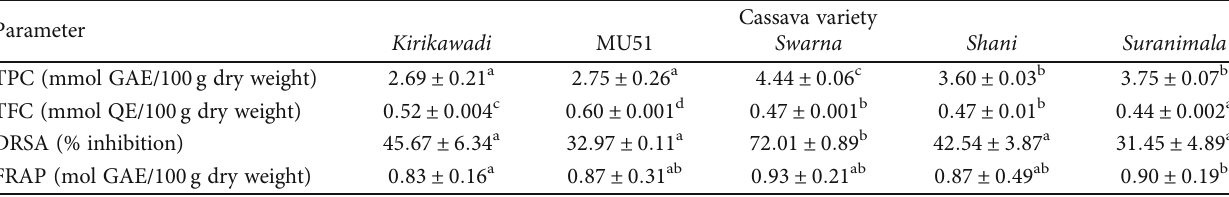
Values are expressed as mean ± standarddeviation of three independent determinations. Di ff erent superscripts in a row represent signi fi cantly di ff erent samples ( p < 0 : 05 ). TPC: total phenolic content; TFC: total fl avonoid content; DRSA: DPPH radical scavenging activity; FRAP: ferric reducing antioxidant